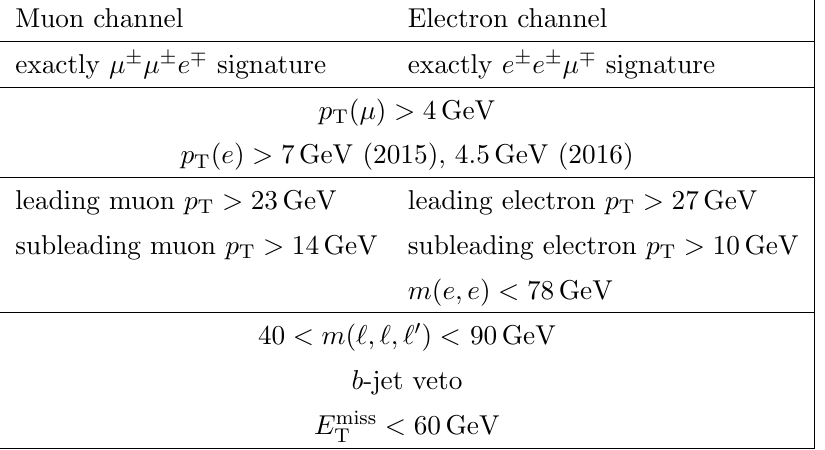
Table 1. Signal region selection criteria for the prompt trilepton analysis.